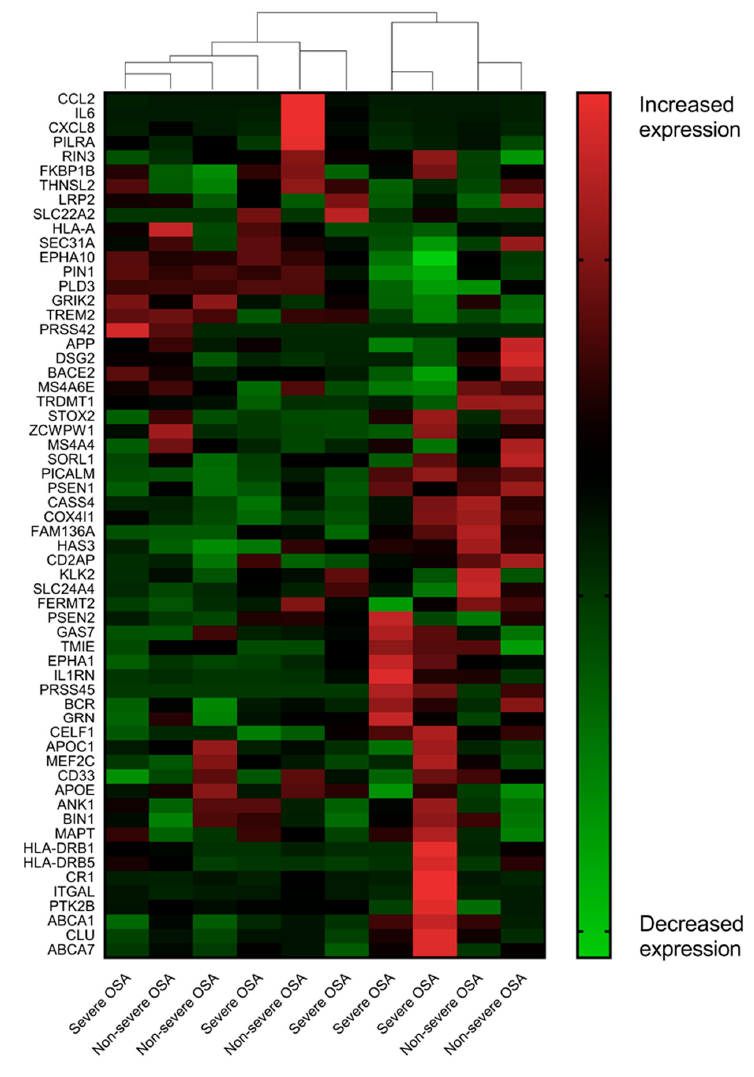
Figure 1. Alzheimer’s disease-associated transcriptome of the uvula tissue from the patients with severe OSA and non-severe OSA. In this analysis, we made no a priori designation of a subject’s phenotype (severe OSA, non-severe OSA control) when clustering individuals based on their oropharyngeal gene expression patterns. The results implied that severe sleep apnea elicited modest perturbations in the AD-associated transcriptional response of the oropharynx. Table 2. Expression of representative Alzheimer’s disease-associated genes among the patients with severe OSA and non-severe OSA in descending order by probability.